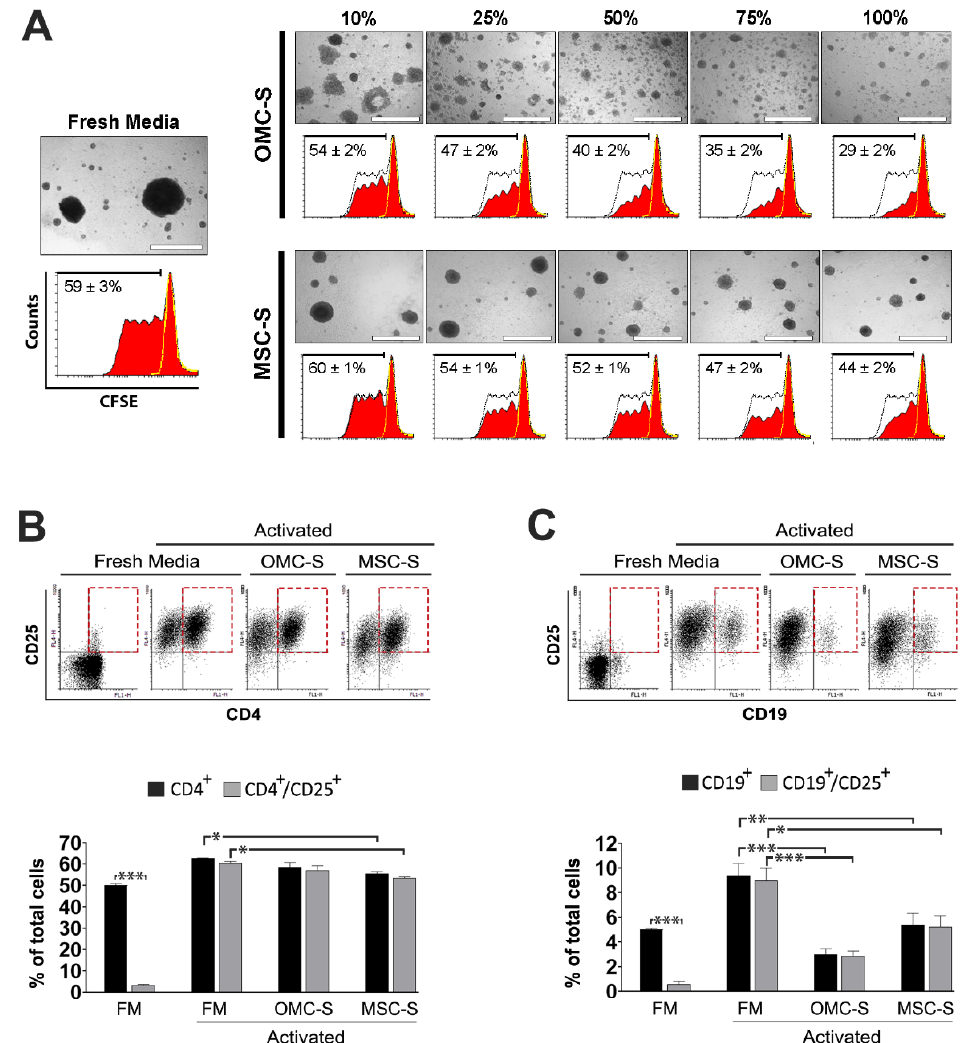
Figure 6. OMC-derived secretome inhibits the proliferation of human lymphocytes and the activation of B cells. ( A ) Representative images (upper panel) of a mixed lymphocyte reaction (MLR) of PBMC-enriched lymphocytes labeled with CFSE and cultured in either 100% fresh media (FM) supplemented with 25 µ g/mL phytohemagglutinin (PHA) or increased amounts of OMC-S and MSC-S supplemented with PHA. Scale bar is 500 µ m. Lower histograms depict corresponding CFSE expression levels (red histograms) of disaggregated lymphocyte cultures. The yellow dashed line marks cells freshly labeled with CFSE. For reference, a black dashed line corresponding to CFSE expression histogram in 100% FM is shown in OMC-S and MSC-S histograms. Results are shown as mean percentages ± s.e.m of CFSE low cells calculated from n = 2 independent batches of OMC-S (ALIC1, SEV1) and MSC-S. ( B , C ) OMC-S efficiently suppress B cells activation. Human PBMC-enriched lymphocytes subjected to double polyclonal stimulation (anti-CD3/CD28; PHA) were expanded for 6 days and finally incubated for 2 days in FM, OMC-S, or MSC-S. Cells were analyzed by flow cytometry. ( B ) Analysis of CD4 and CD25 coexpression. Upper panel shows representative dot plots of CD4/CD25 expression. Lower graph, quantification of mean percentages of total CD4 + T cells and CD4 + /CD25 + -activated T cells. ( C ) Flow cytometry analysis of CD19 and CD25 coexpression. Upper panel shows representative dot plots of CD19/CD25 expression. Lower graph, quantification of mean percentages of total CD19 + B cells and CD19 + /CD25 + activated B cells. ( B , C ) Results are mean ± s.e.m results of n = 3 distinct batches of OMC-S (ALIC1, SEV1, and SEV3) and MSC-S. Statistical differences were calculated using ANOVA. * is for p ≤ 0.05; ** for p ≤ 0.01; *** p ≤